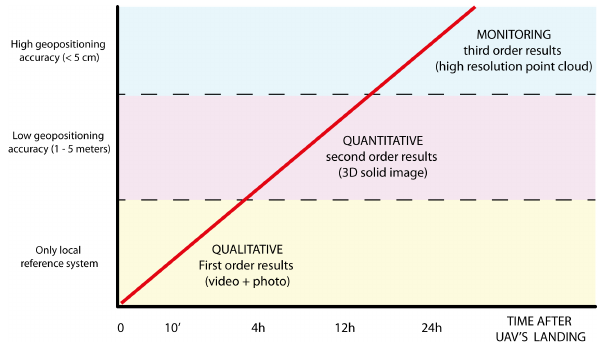
Figure 3. Schematic representation of the different results obtain- able from micro-UAVs surveys in rockfall scenarios. Considering time starting after the UAV’s landing, there is a direct relationship between the orthorectification accuracy level of the obtained results and the processing time. Times in the chart are indicative for a study area similar to the San Germano event, which can be considered as representative of rockfall phenomena involving the road network that can be studied through micro-UAV’s surveys. The processing time is also dependent on the areal extent of the study area and computational